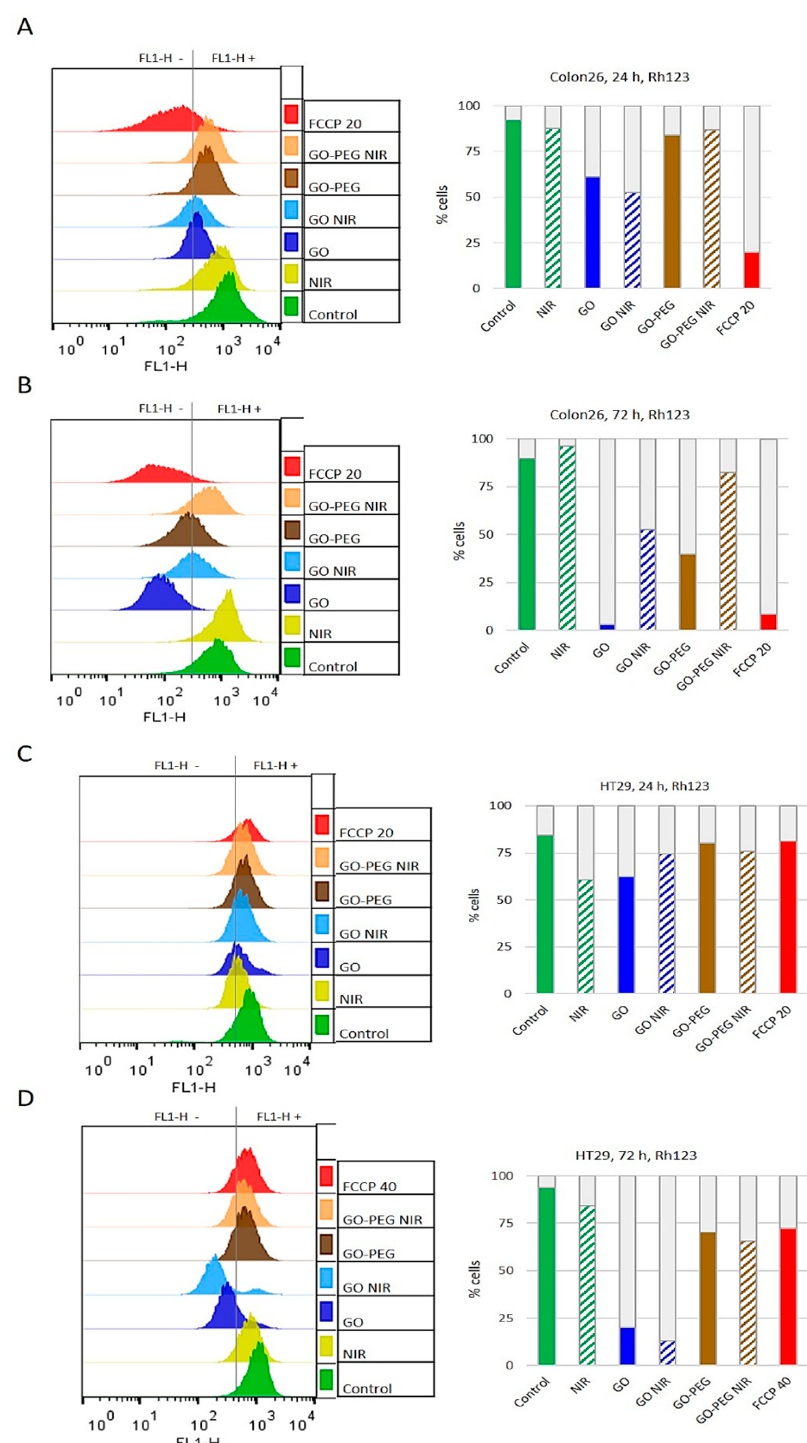
Figure 7. Mitotoxicity of GO nanoparticles and NIR by Rhodamin123 staining assessed by FACS observation. The mitochondrial activity was detected by FACS based on the incorporation of ∆Ψ - sensitive Rh123 fluorescent dye in viable cells. Histograms represent Rh123 fluorescence acquired by flow cytometer using FL1-H detector. The charts show the distribution of gated viable cells (FSC/SSC) according to the intensity of their Rh123 (FL1-H) fluorescence. ( A ) Colon26 cells after 24 h incubation with NPs. ( B ) Colon26 cells after 72 h of NPs treatment. ( C ) HT29 cell—24 h after incubation with NPs. ( D ) HT29 cells—72 h of treatment with NPs.